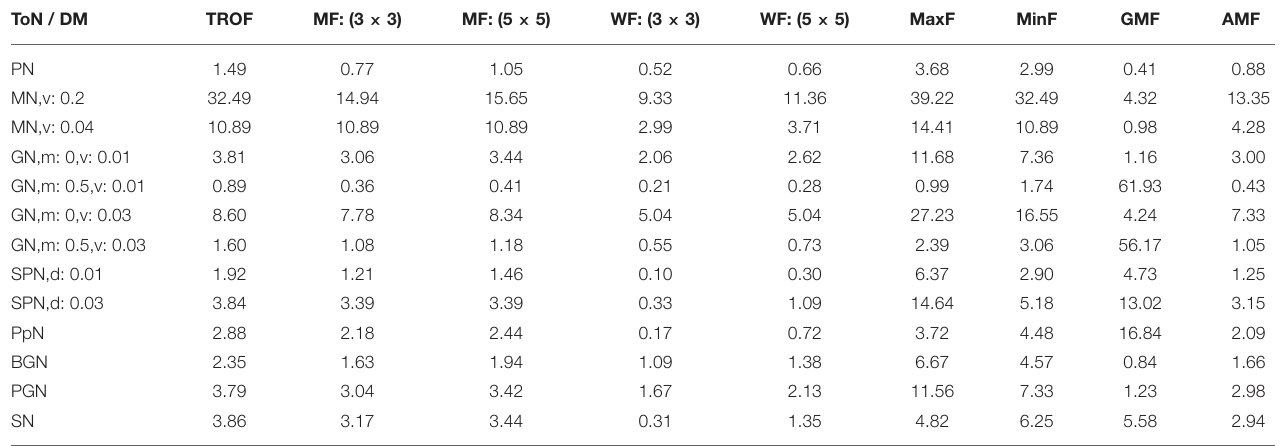
TABLE 7 | Comparison of variance between denoised image and original image.